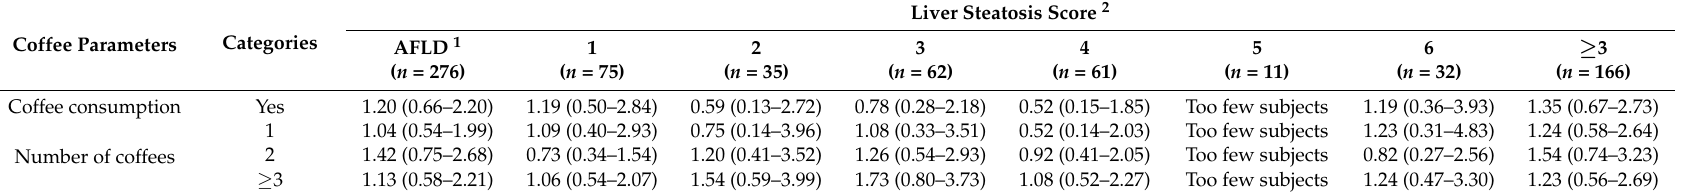
Table 3. Association between coffee consumption and liver steatosis in people with Alcoholic Fatty Liver Disease (AFLD)